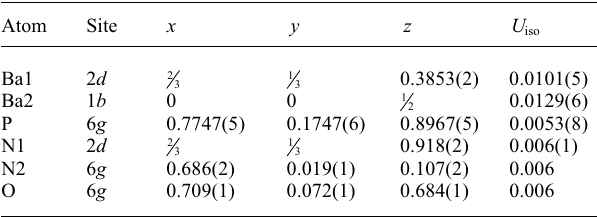
Table 2. Atomic coordinates and displacement parameters (in Å 2 ) . Table 1. Data collection and